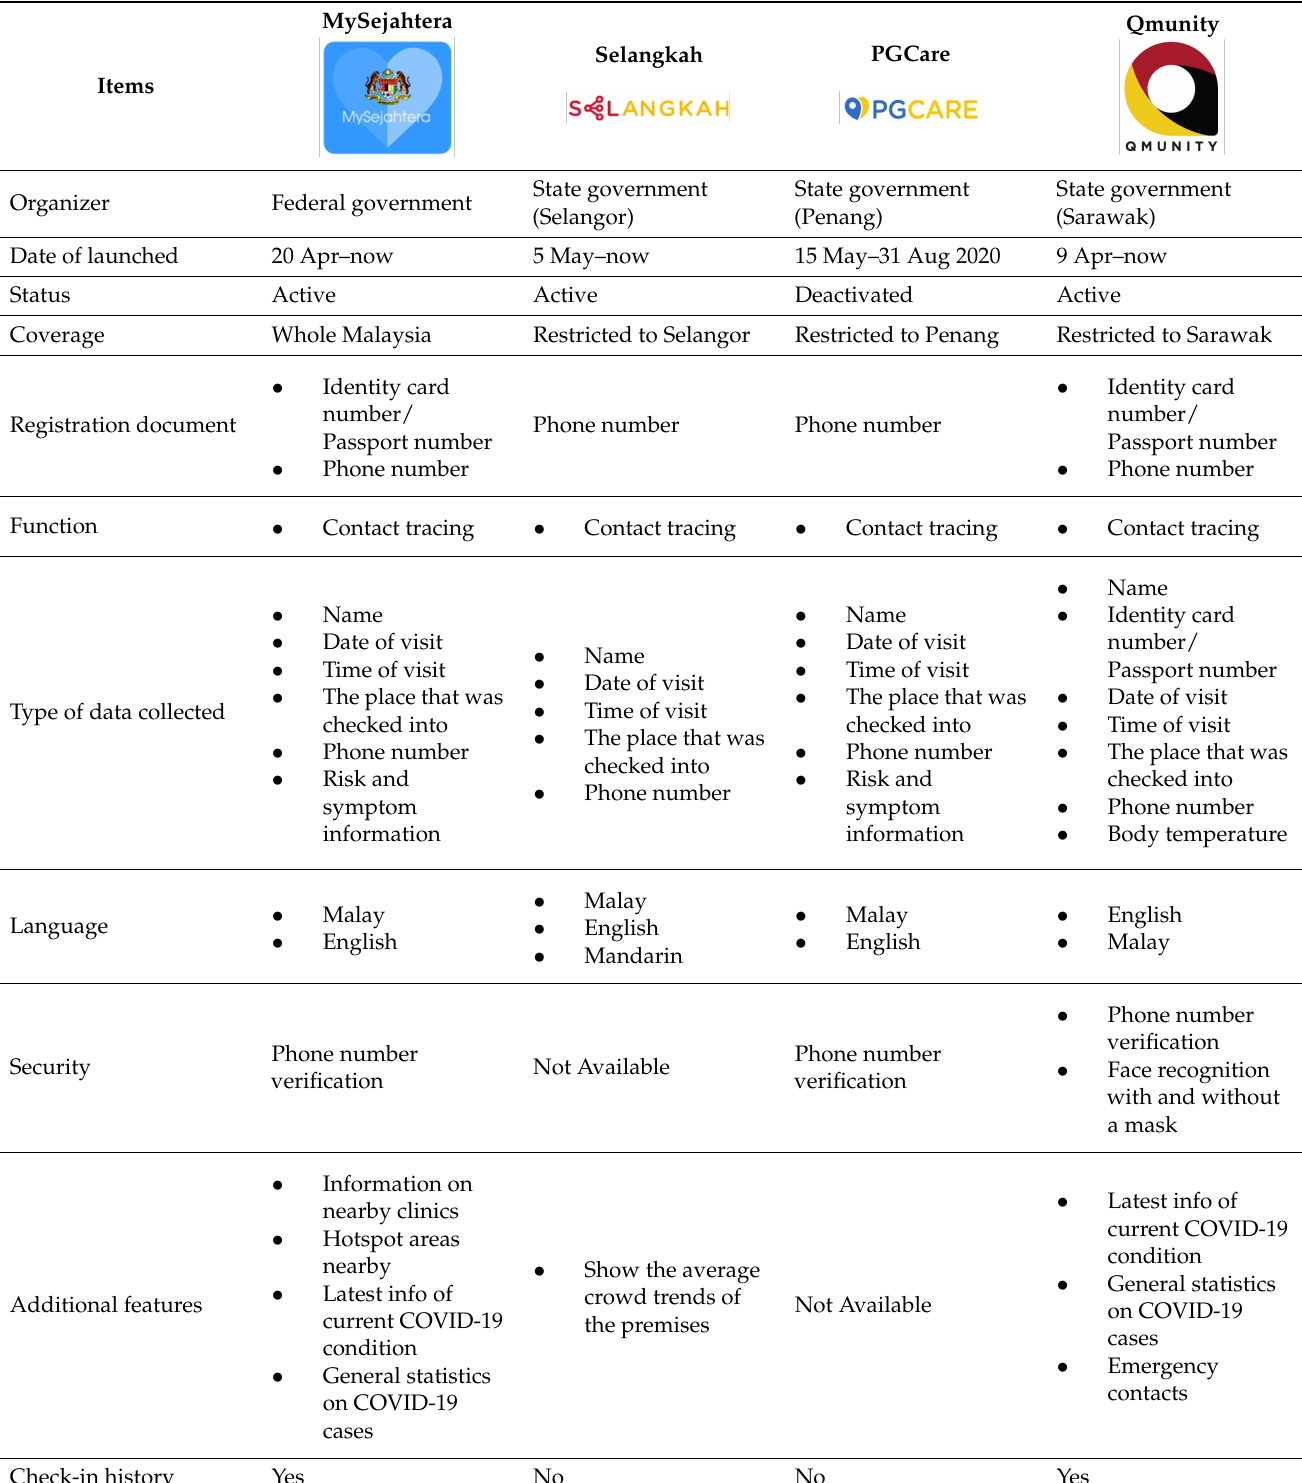
Table 3. The comparison of COVID-19 contact tracing applications in